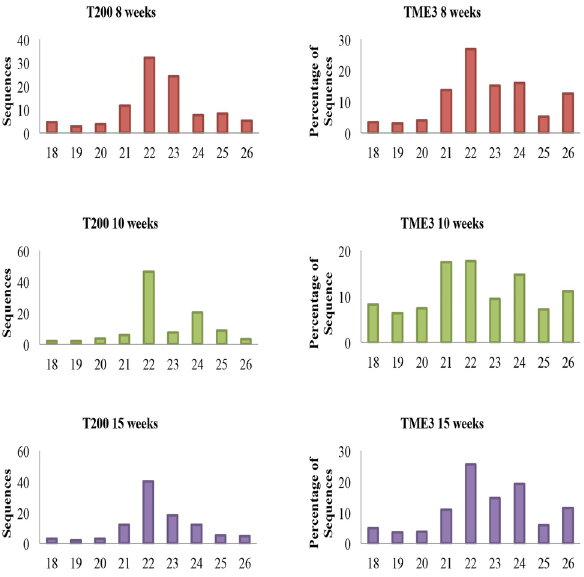
Fig 1. Sequence length distribution of cassava small RNAs from T200 and TME3 landraces. Percentage of sequences of 18 – 26 nt length for each of the six sequenced libraries. The majority of the generated reads were 21 to 24 nt in